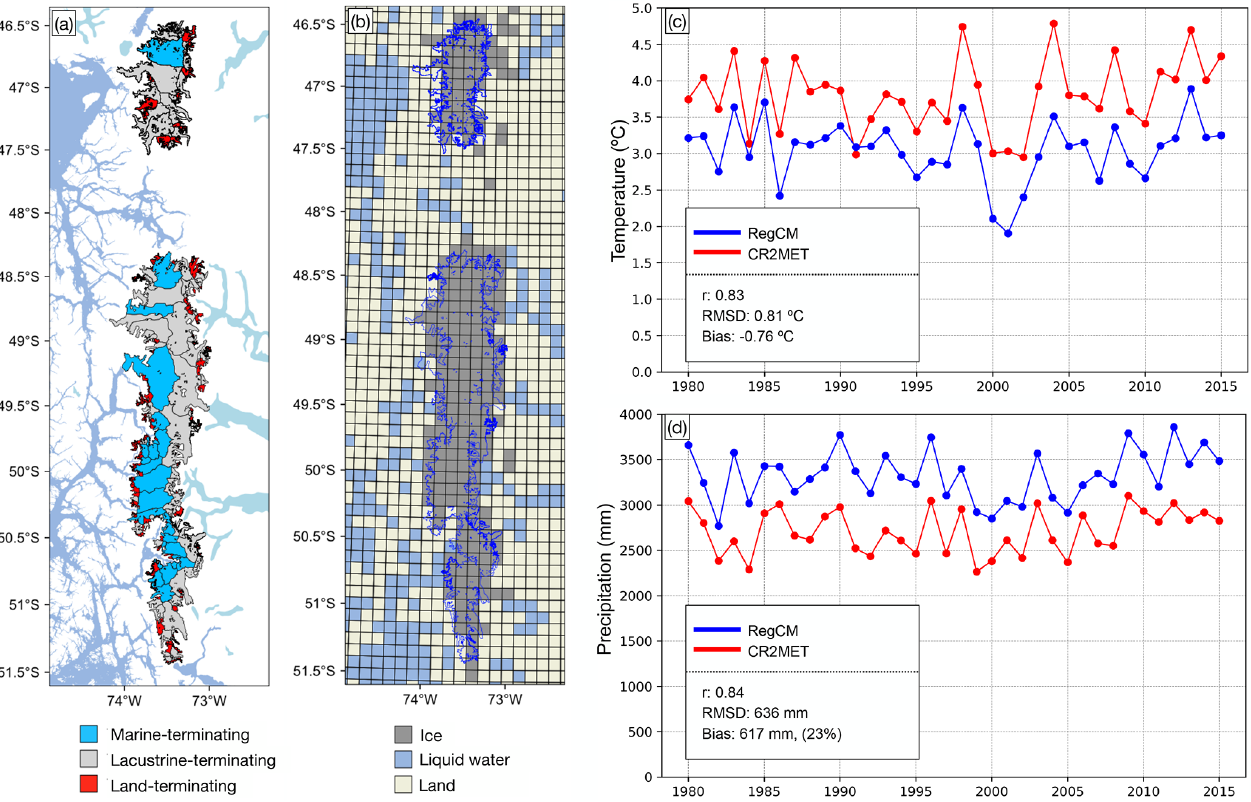
Figure 2. (a) Patagonian Icefields together with their glacier divides and type of terminus. (b) The RegCMv4 grid ( ∼ 10km spatial reso- lution), the model land use (grid box colors), and the NPI and SPI outlines (blue contours). (c) Comparison of annual mean temperature time series (box at 46–52 ◦ S and 72.5–74.5 ◦ W) using RegCMv4 data and CR2MET data. (d) The same as (c) but for accumulated annual